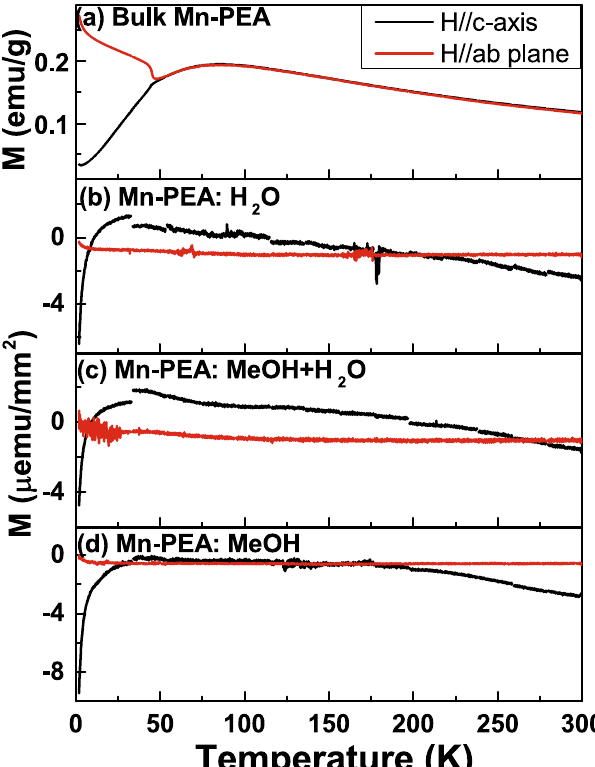
Figure 6. Temperature dependence of magnetization (M-T curve) of ( a ) bulk single crystal Mn-PEA, ( b ) Mn- PEA:H 2 O, ( c ) Mn-PEA:MeOH + H 2 O, and ( d ) Mn-PEA:MeOH thin films. M-T curves were measured for two field orientations where one is parallel to c-axis and the other is parallel to ab-plane. Each was measured under a magnetic field of 0.5 T from 2 K to 300 K after field cooling to 2